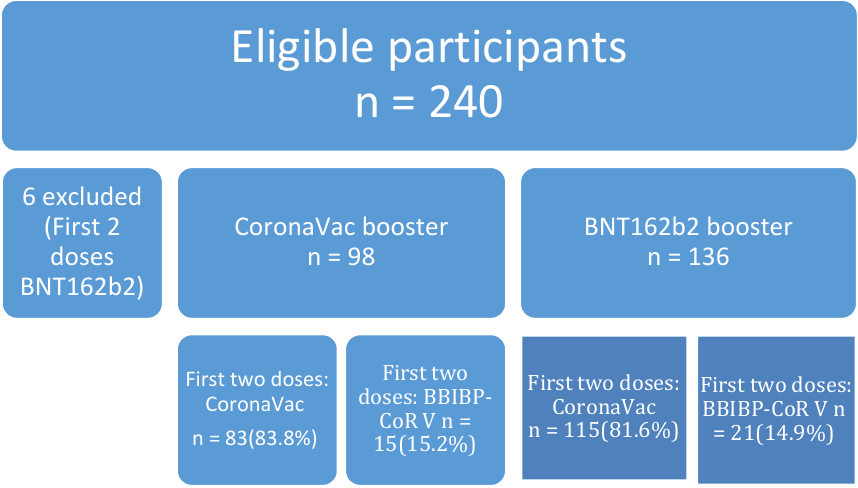
Figure 1. Participant’s recruitment and their corresponding primary vaccination status. Table 1. Demographic characteristics and pre-existing co-morbidities 1 .